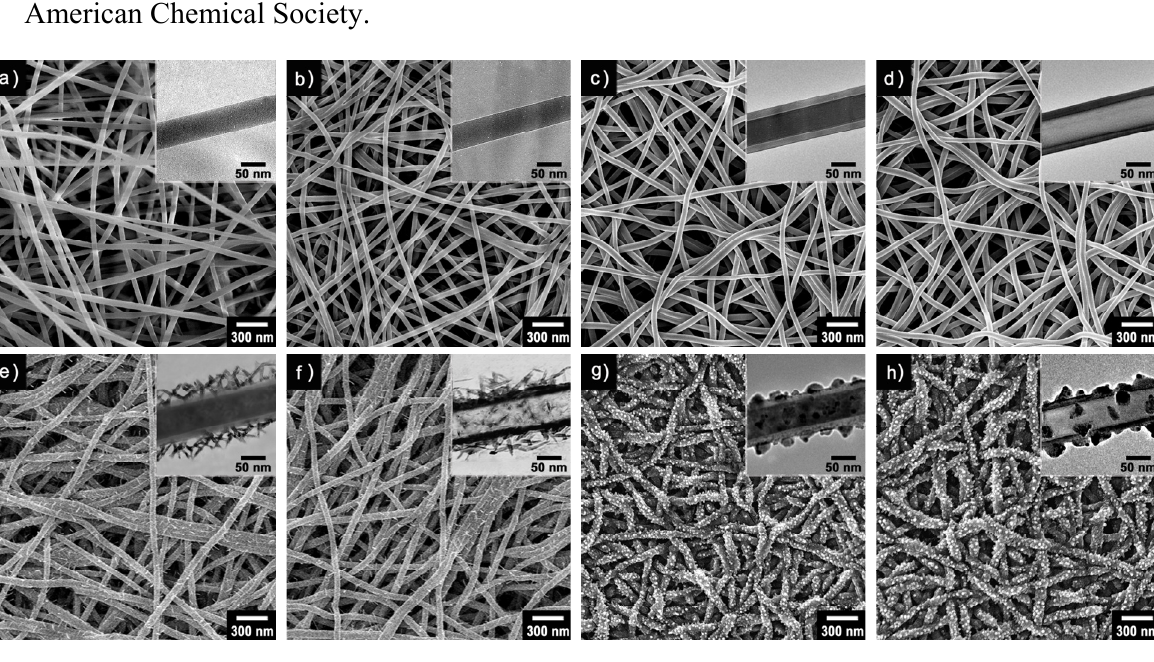
Figure 1. Multidimensional poly(3,4-ethylenedioxythiophene) (PEDOT) nanostructures with unique surface substructures. ( a – h ) The poly(methyl methacrylate) (PMMA) nanofibers function as a template and substrate for the growth of PEDOT under different synthetic conditions (temperature and pressure). The morphologies of the resulting transmission electron microscopy (TEM) (right top inset images): PMMA nanofibers ( a ) before and ( b ) after ferric ion adsorption; PMMA/PEDOT nanofibers with smooth layer surface ( c ) before and ( d ) after core etching; PMMA/PEDOT nanofibers with nanorod surface ( e ) before and ( f ) after core etching; PMMA/ PEDOT nanofibers with nanonodule surface ( g ) before and ( h ) after core etching. With permission from [33]; Copyright